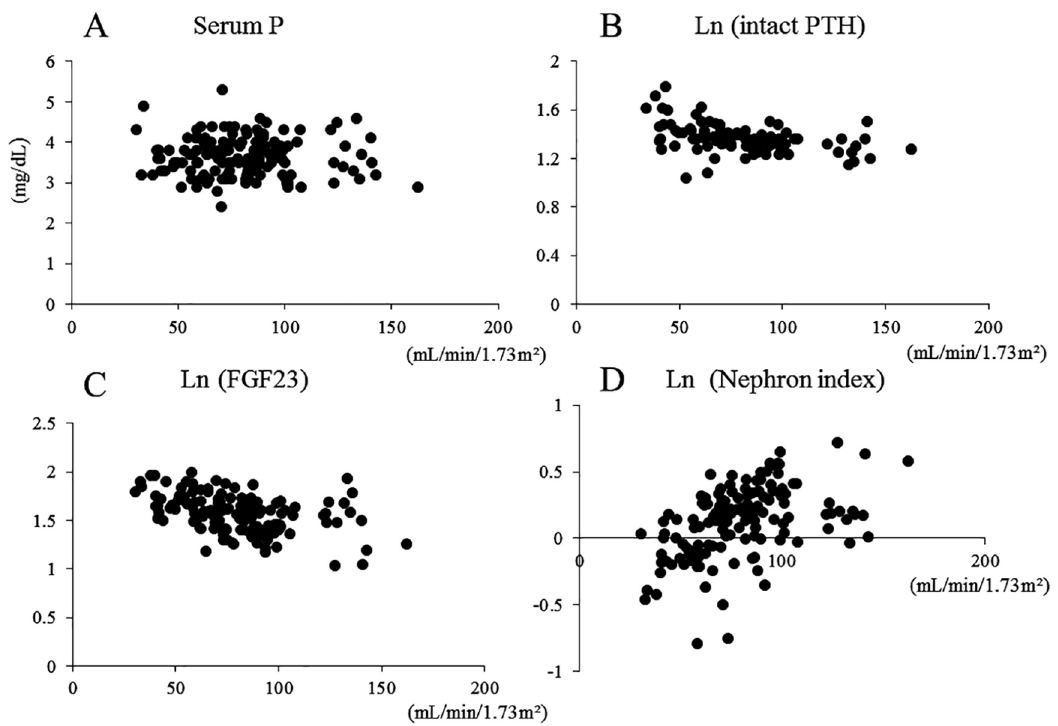
Fig 2. Simple regression analyses of serum P. ( A ), Ln intact PTH ( B ), Ln FGF23 ( C ), and Ln Nephron index ( D ) with eGFR in diabetic patients. Pearson ’ s correlation coefficients were calculated. FGF23, fibroblast growth factor 23; Ln, logarithmic